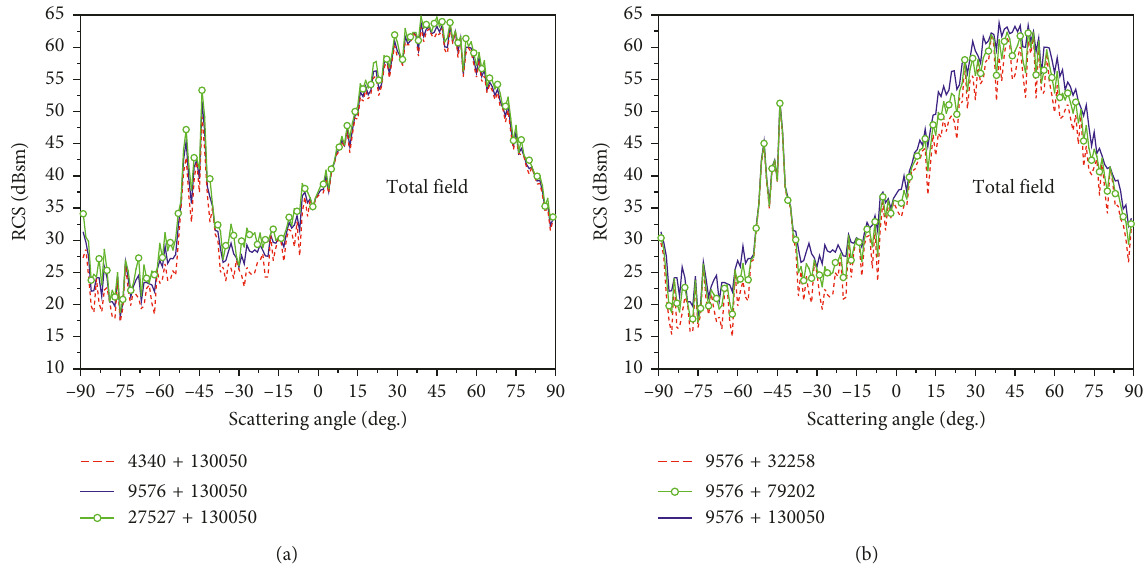
Figure 9: The RCS of total field from the ship and sea surface. (a) With different number of patches on the ship. (b) With different number of patches on sea